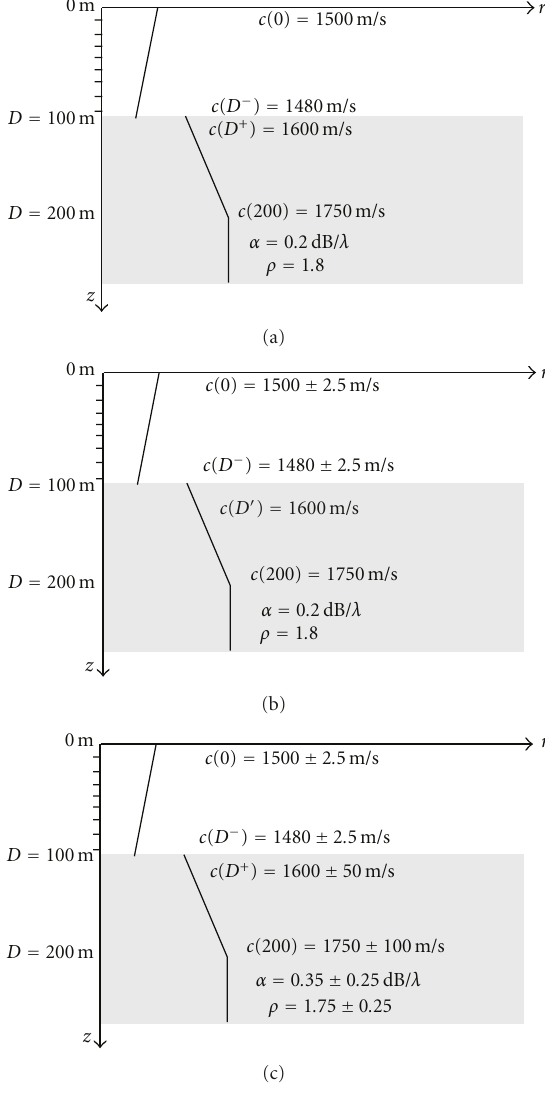
Figure 1: Environmental information provided for true environ- mental parameters (a), SSPMIS (b), and GENLMIS